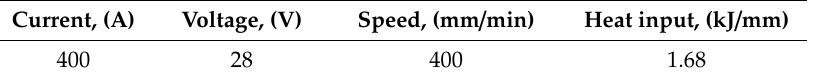
Table 6. Welding